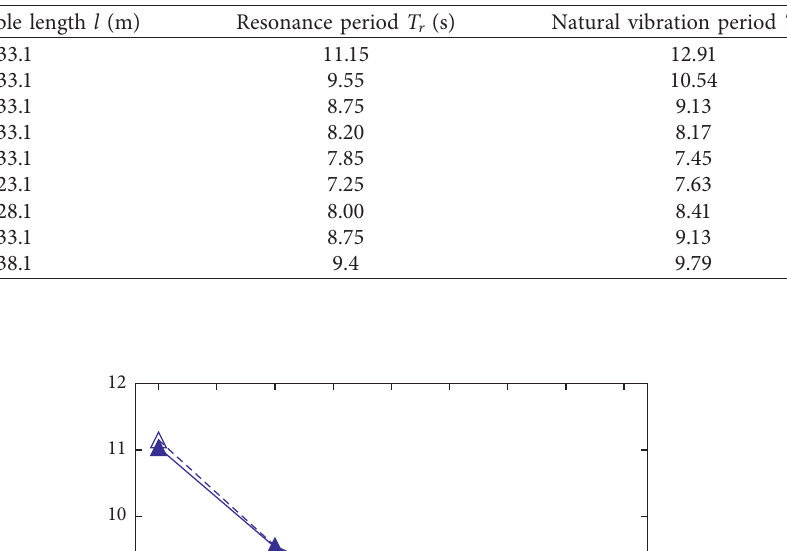
Table 3: The resonant period and natural vibration period of the tube.